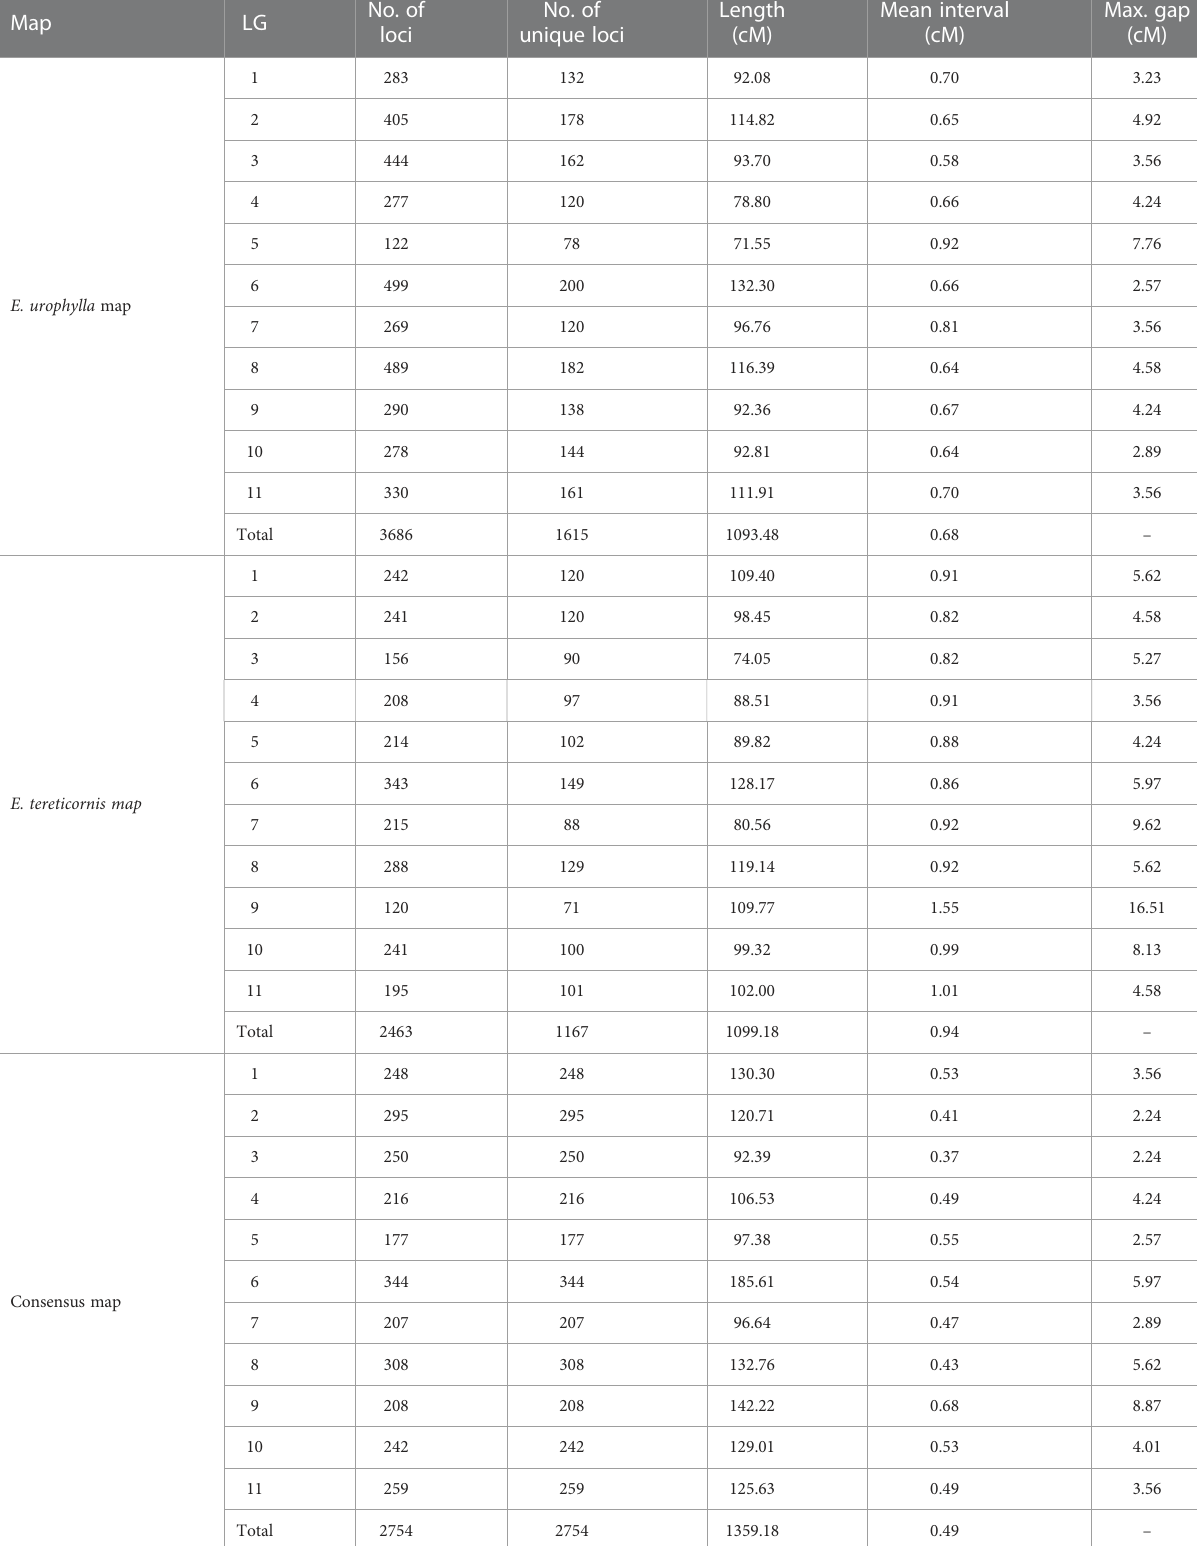
TABLE 1 Locus statistics of E. urophylla map, E. tereticornis map and consensus map. Map LG